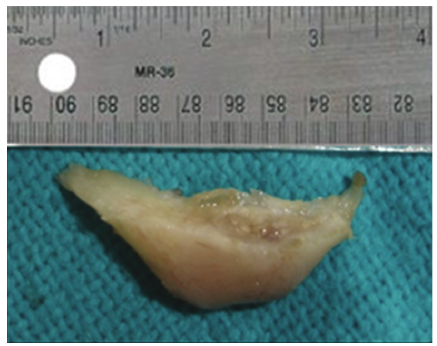
Figure 11: Resected angle.